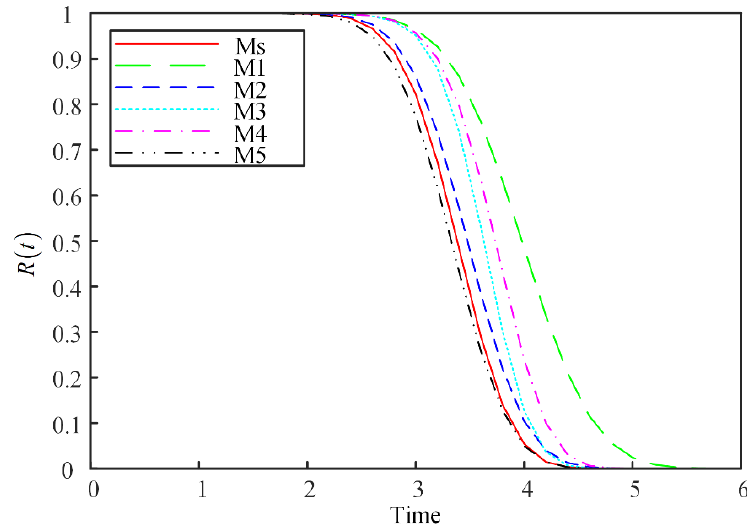
Figure 5. Reliability estimation results for different models.